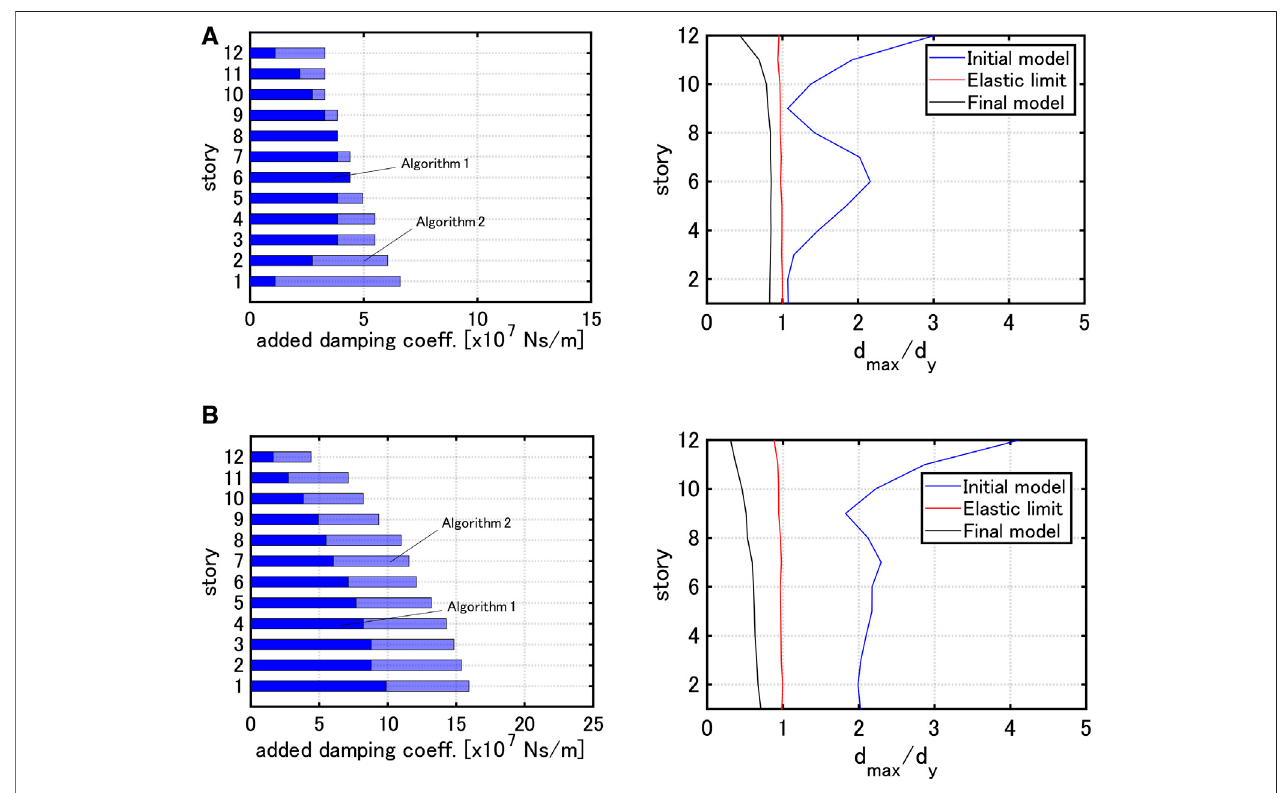
FIGURE5| Distributionofaddeddampingcoef fi cientsanddistributionof d max , i / d y undercriticaldoubleimpulseforModel2: (A) V (cid:2) 0 . 84 [ m / s ] , (B) V (cid:2) 1 . 23 [ m / s ] (Akehashi and Takewaki, 2019).